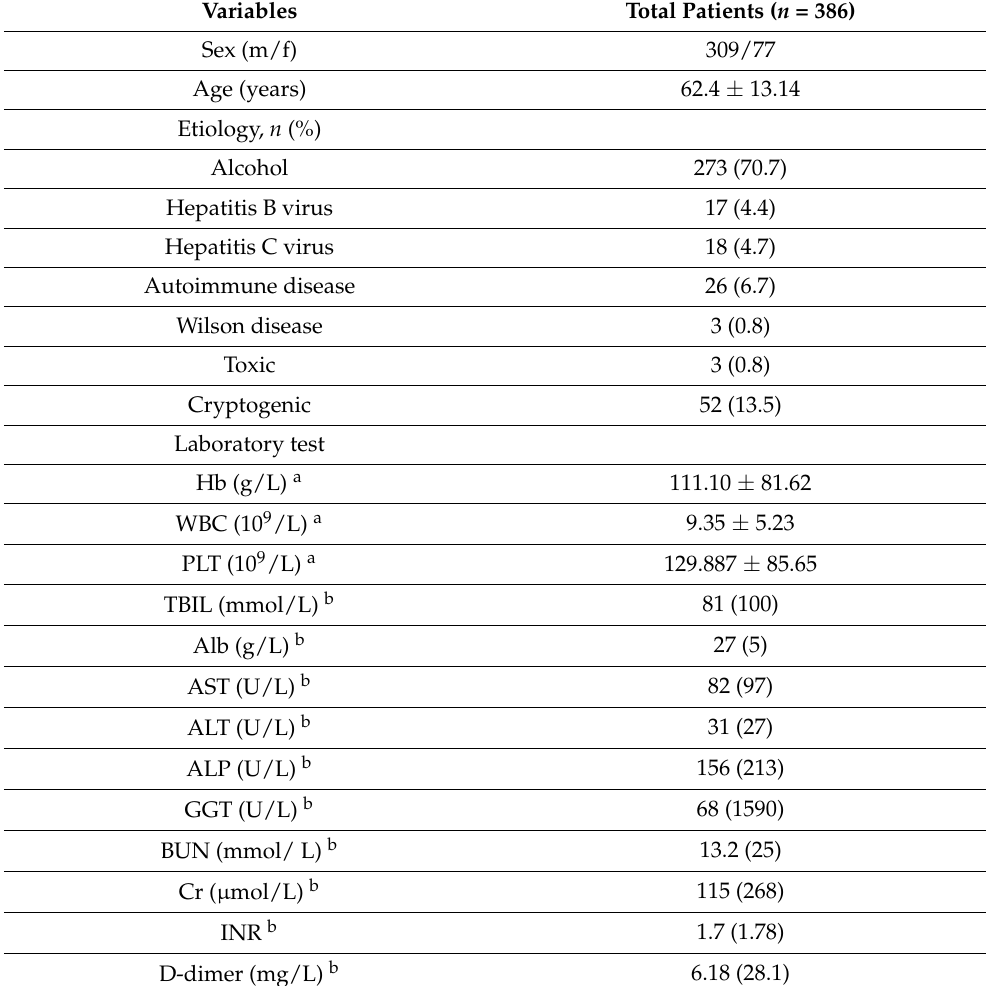
Table 2. Clinical characteristics and laboratory data in patients with liver